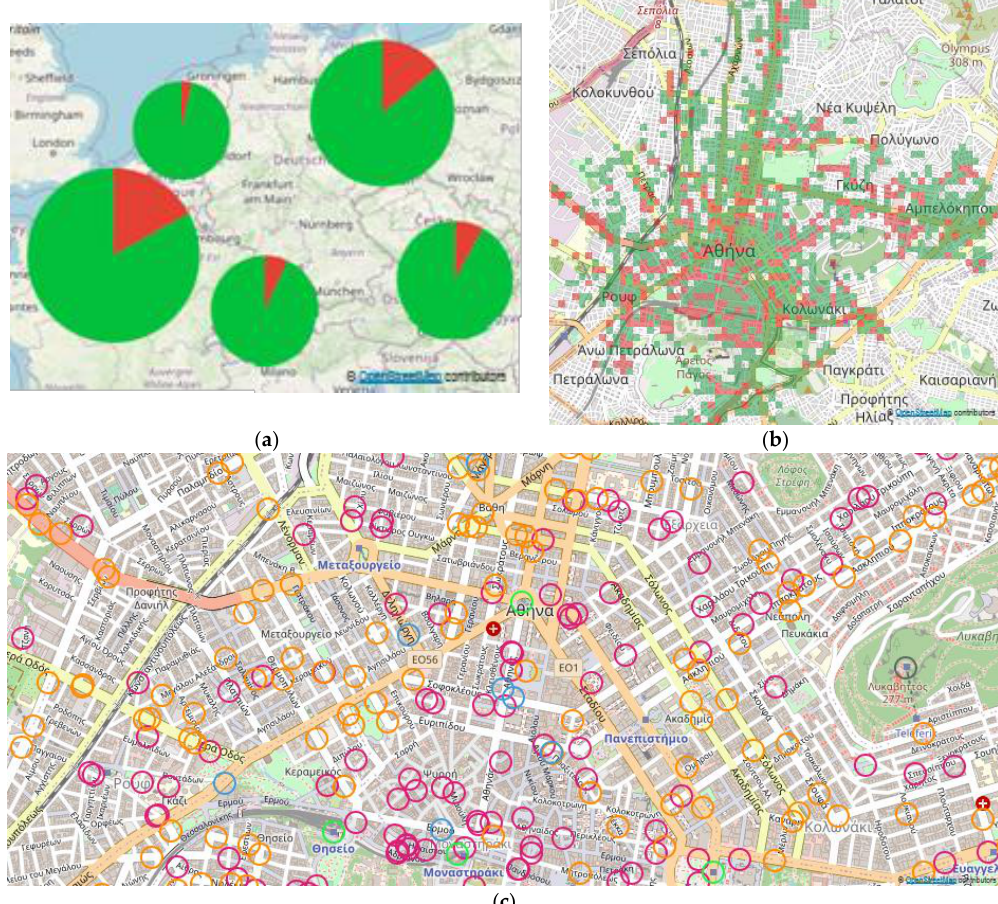
Figure 5. Consistency visualization at different levels and scales: ( a ) regional (i.e., Europe), ( b ) city (e.g., Athens), and ( c ) feature levels (e.g., POI).